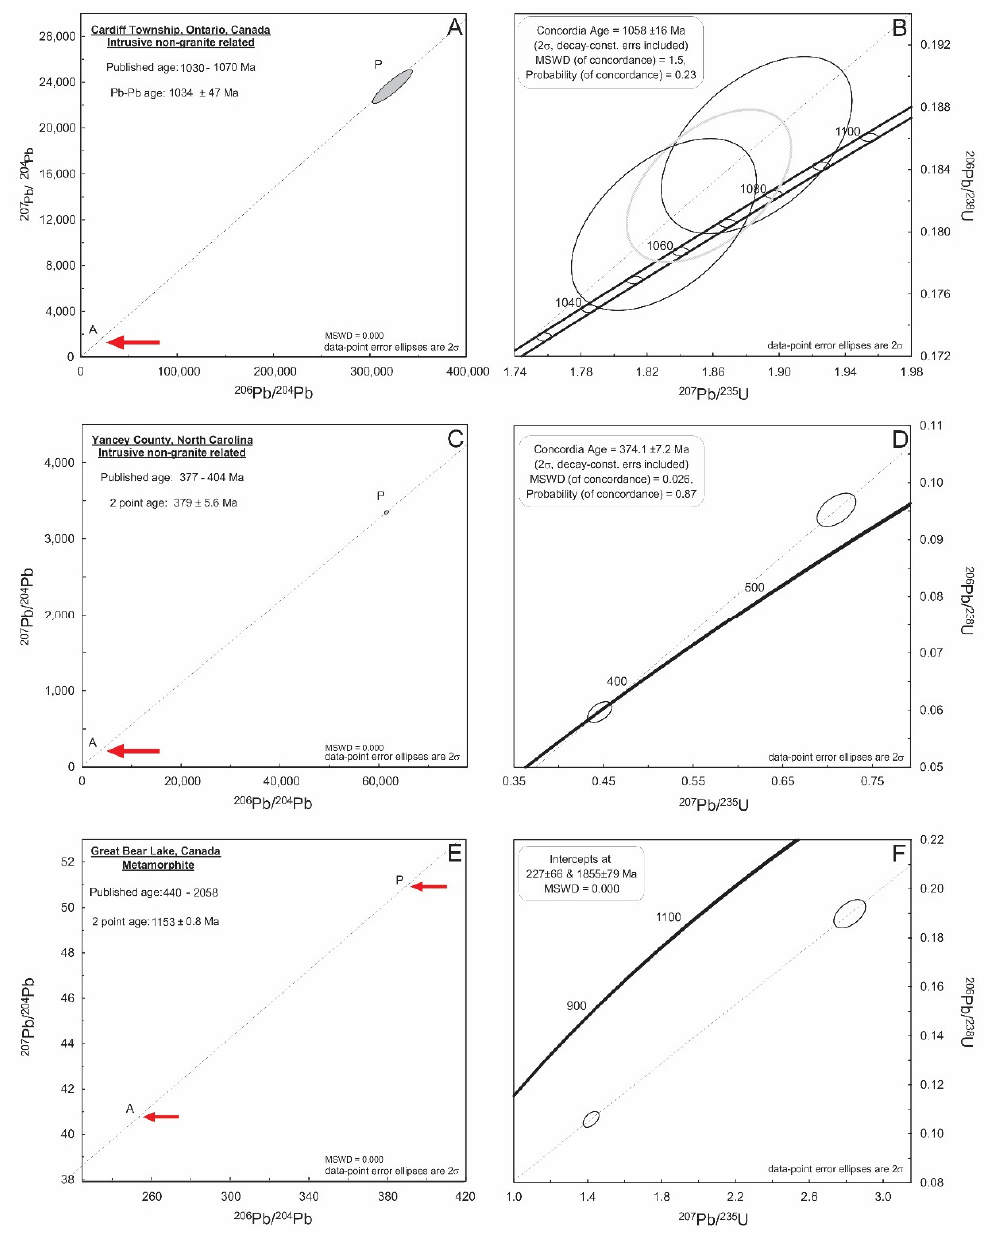
Figure 4. Secondary Pb–Pb isochrons plots and corresponding Concordia diagrams illustrating results for Cardiff ( A,B ), Yancey ( C,D ), and Great Bear ( E,F ) uraninite samples. Symbol size (including associated uncertainty) for certain analyses within the secondary Pb–Pb isochrons are difficult to see, due to large range (scaling) of Pb isotope compositions. Therefore, a red arrow is shown to indicate the position of these analyses. Ellipses for calculated U–Pb ratios for samples illustrated in Concordia plots encompass all sources of uncertainty, and these have been propagated at the 2 level (average of ~2.5%).